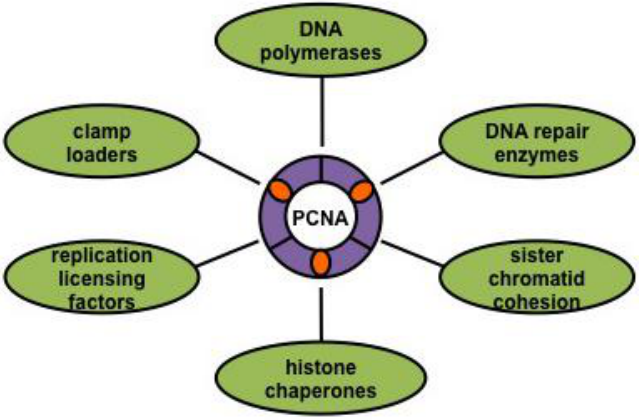
Figure 4. PCNA is a node of protein-protein interaction in the replisome. The PCNA homotrimer interacts with proteins in diverse processes. Many of the protein-protein interactions occur through a PCNA binding motif known as the PIP box, which binds a central domain on PCNA